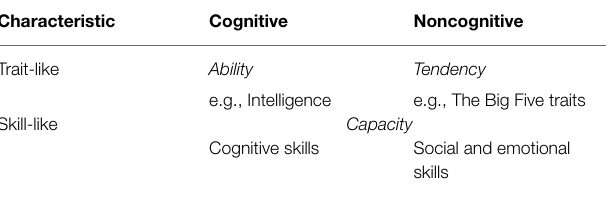
TABLE 1 | Different types of characteristics fostering success and well-being.